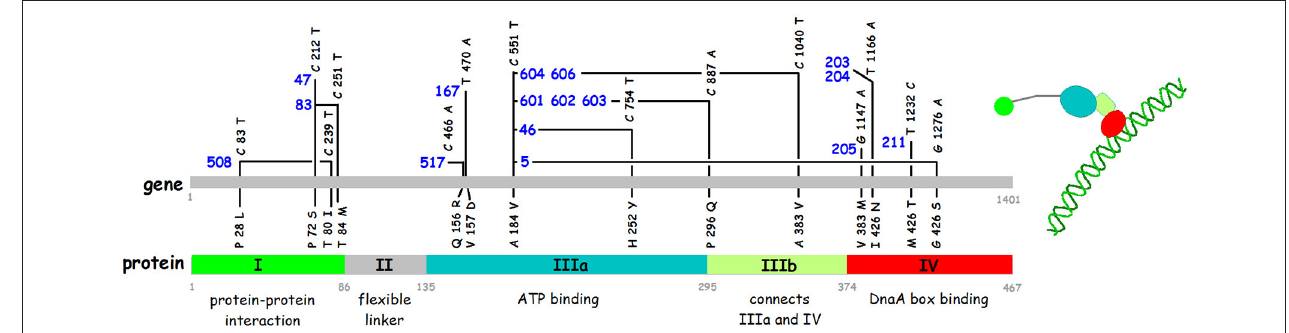
FIGURE 5 | Nucleotide and amino acid alterations in the dnaA gene of sixteen temperature sensitive mutants. The mutant numbers are in blue. References for the isolation of the different mutants are: dnaA508 , dnaA517 (Wechsler and Gross, 1971); dnaA47 (Kuempel, 1969); dnaA46 , dnaA83 (Kohiyama et al., 1966); dnaA167 (Abe and Tomizawa, 1971); dnaA601 , dnaA602 , dnaA603 , dnaA604 , dnaA606 (Sevastopoulos et al., 1977); dnaA203 , dnaA204 , dnaA205 , dnaA211 (Beyersmann et al., 1974). The sequences of 12 of these mutants are described by Hansen et al. (1992). The four mutations dnaA47 , dnaA83 , dnaA517 , and dnaA603 were sequenced using PCR fragments obtained from the original mutant strains (this work). The domains in the DnaA protein and the borders between them are shown in the lower part of the figure.